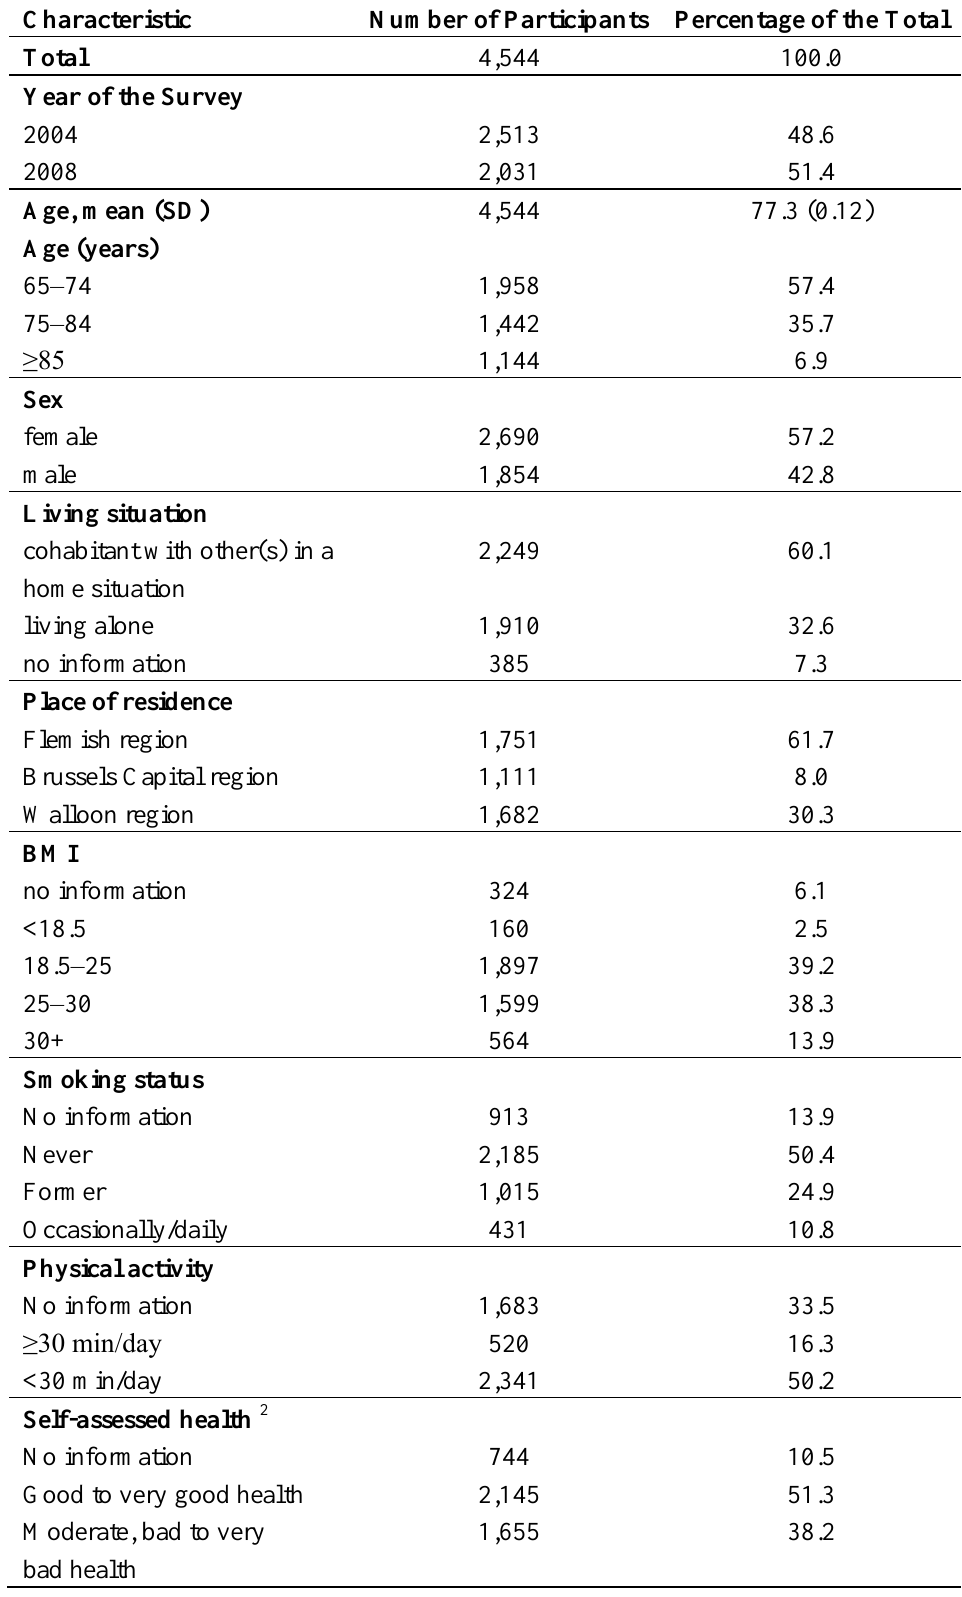
Table 1. Characteristics of the study population (absolute figures and weighted 1 percentages). Characteristic Number of Participants Percentage of the Total Total 4,544